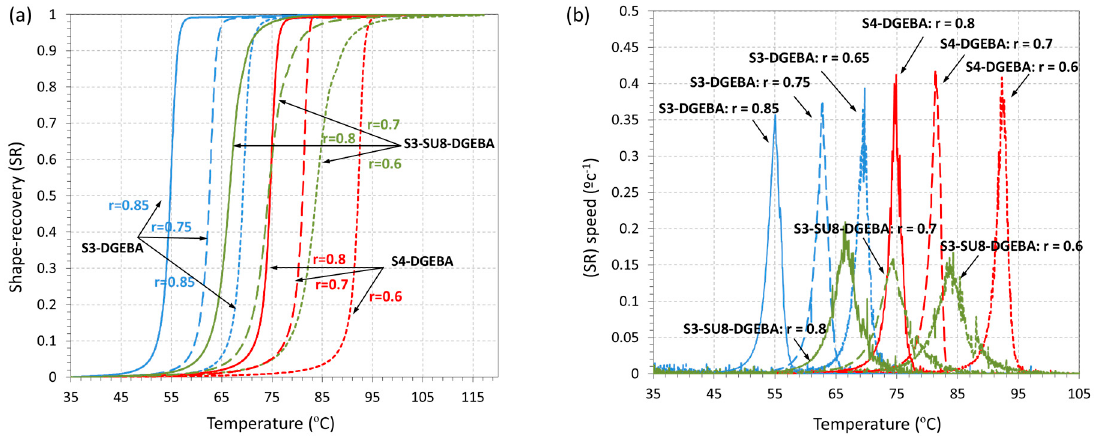
Figure 8. Shape-memory unconstrained recovery experiments: ( a ) shape-recovery as function of temperature; and ( b ) derivative of shape-recovery with respect to temperature ( SR speed ) as function of temperature.